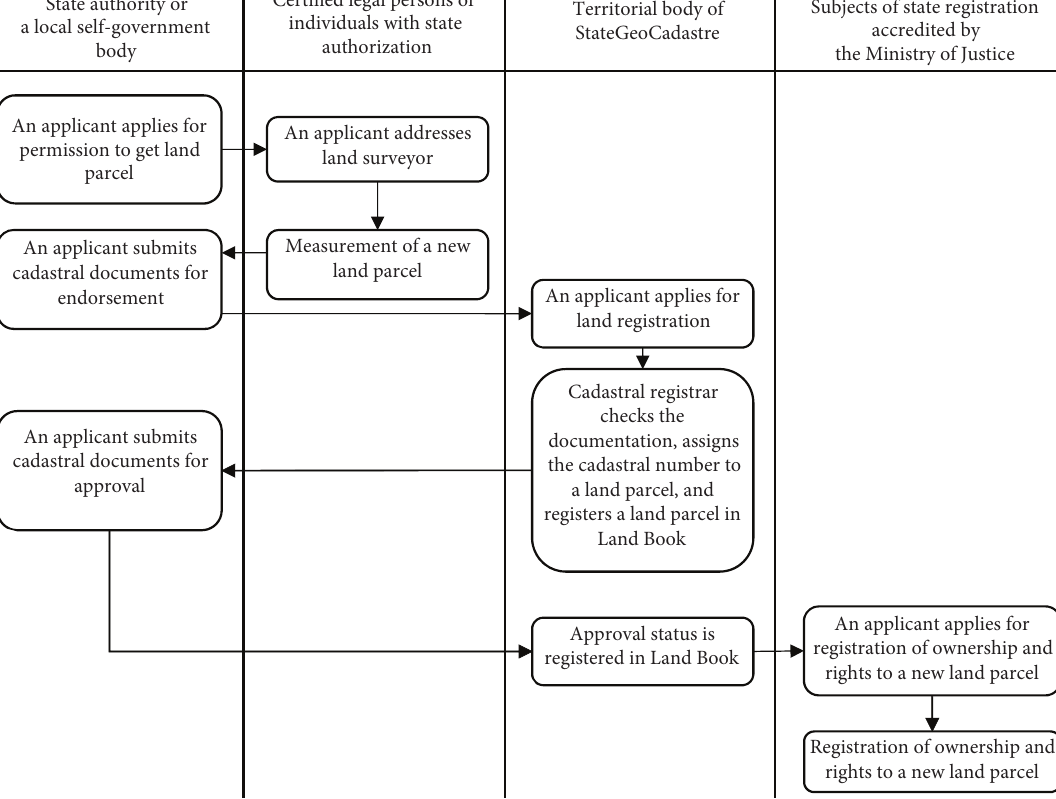
Figure 2. The simplified diagram of the initial state land registration in